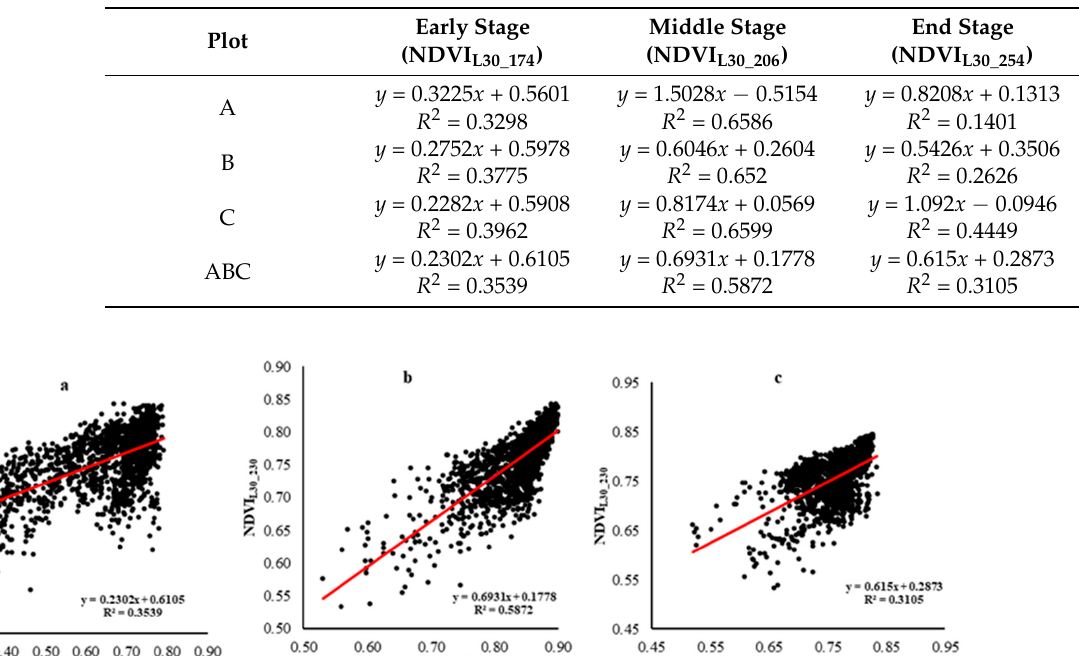
Table 2. Results of linear regression between the fusion product NDVI F500_230 using different refer- ence dates and NDVI L30_230 in 3 plots.